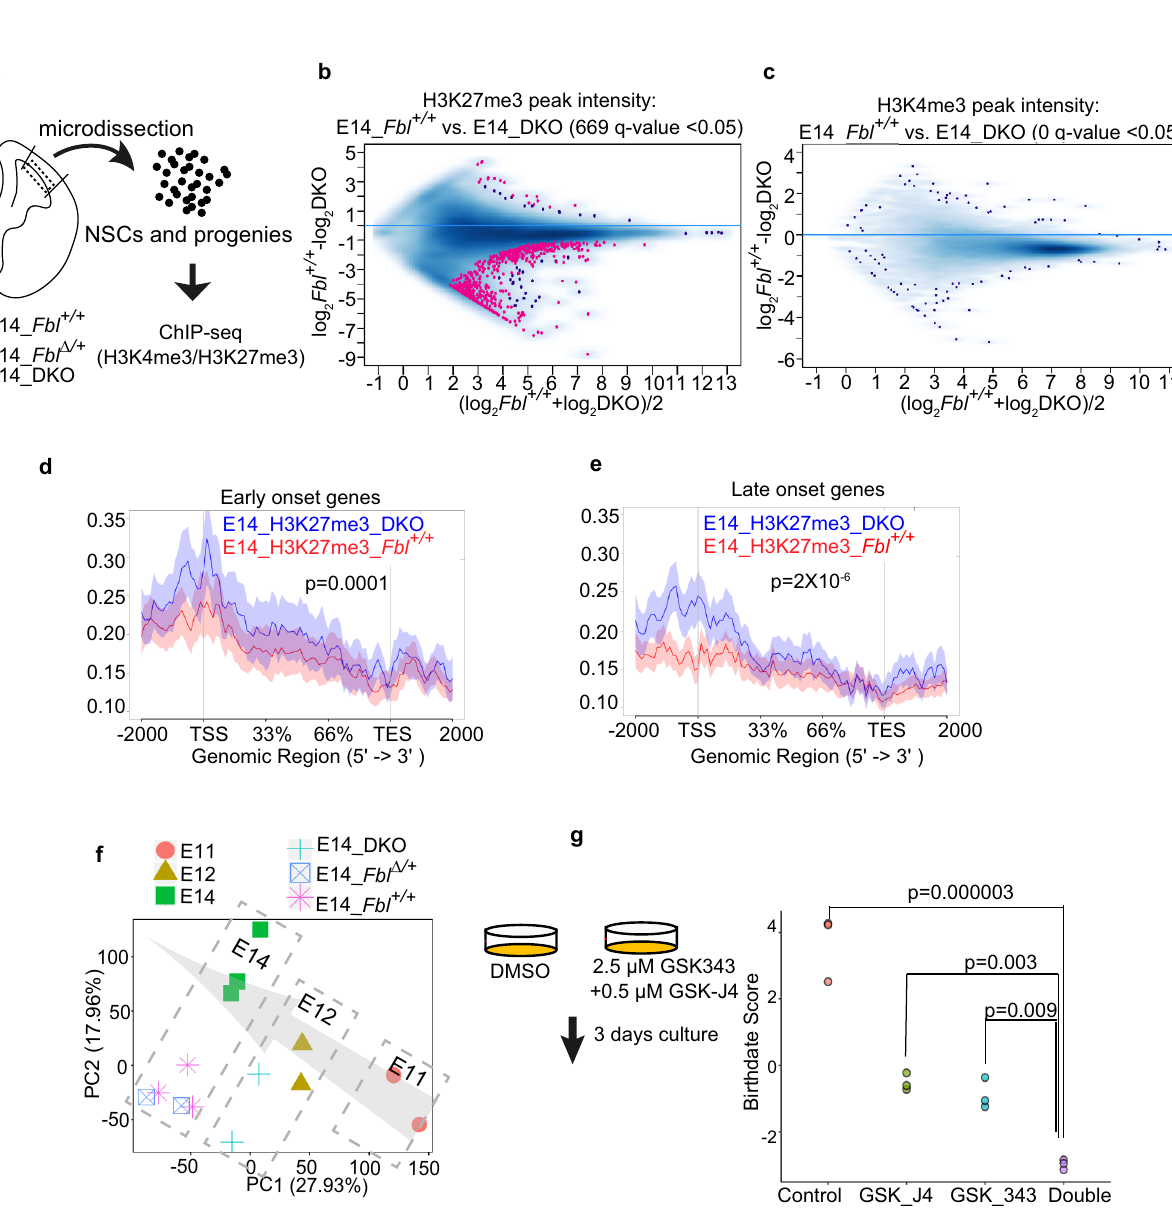
Fig. 6 Genome-wide H3K4me3 and H3K27me3 modi fi cation change during temporal patterning of neural stem cells (NSCs). a Experiment design for chromatin immunoprecipitation and sequencing (ChIP-seq). b H3K27me3 and H3K4me3 change of isolated Hes1 + NSCs from E11 to E14. Lines represent 200-bp chromosome regions. c , d Intensity comparison of H3K27me3 ( c ) and H3K4me3 ( d ) peaks between E11 and E14 NSCs, showing that H3K27me3 changed more dramatically than H3K4me3. Peaks with q -value < 0.05 are shown in red. e – h Read-density pro fi ling of H3K27m3 ( e , f ) and H3K4m3 ( g , h ) at early-onset ( e , g ) and late-onset genes ( f , h ) in wild-type E11 and E14 NSCs. A two-sided Wilcoxon signed-rank test was used to evaluate the difference between E11 and E14 NSCs. The shaded areas represent standard errors. i , j Principal component analysis (PCA) of H3K27me3 and H3K4me3 peaks showing H3K27me3 samples can represent developmental time. Arrow indicates temporal axes. Different colored dots represent different stages of samples. k , l Top ten GO term of genes, with which stage-speci fi c H3K27me3 peaks are associated.